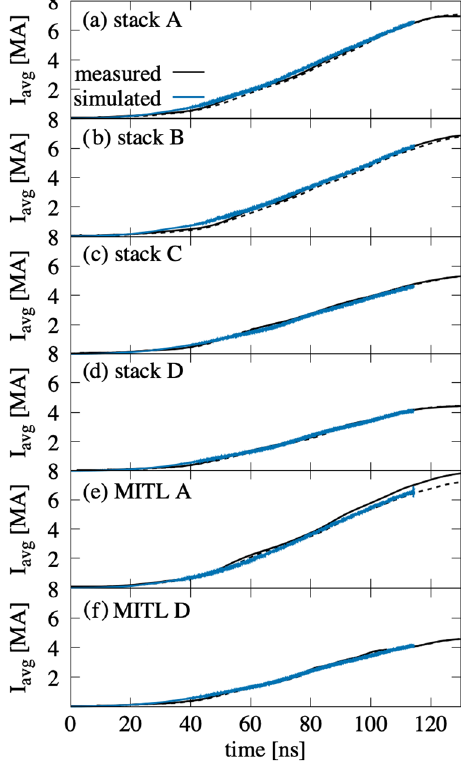
FIG. 5. The voltage drop across the four outer MITL gaps from the simulated electric fields compared to pressure-balance-theory of Eq. (5).